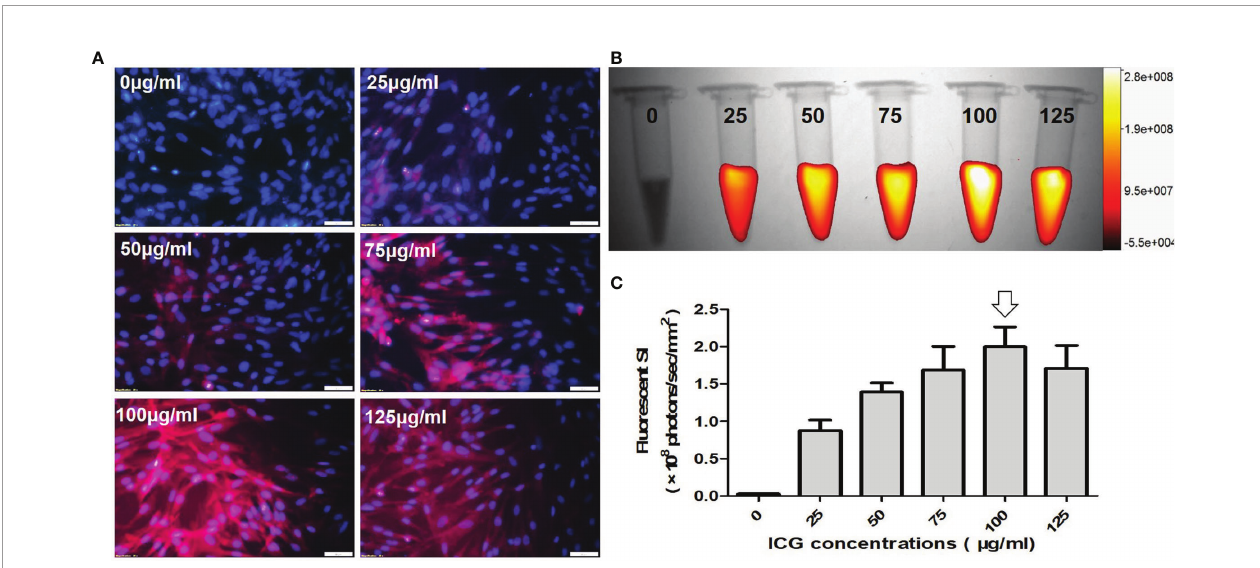
FIGURE 3 | Optimization of indocyanine green (ICG) dose for in-vitro optical imaging of ICG-treated VX2 tumor cells. (A) Fluorescence microscopic images of VX2 cells labeled at different ICG concentrations from 0 m g/ml to 125 m g/ml, showing that ICG-emitting pink fl uorescent signals become more intense as ICG concentration increases (Scale bars, 50 m m). (B, C) Quantitative optical/X-ray images further demonstrate the highest fl uorescent SI at 100 m g/ml (arrow) for suf fi cient ICG uptake by VX2